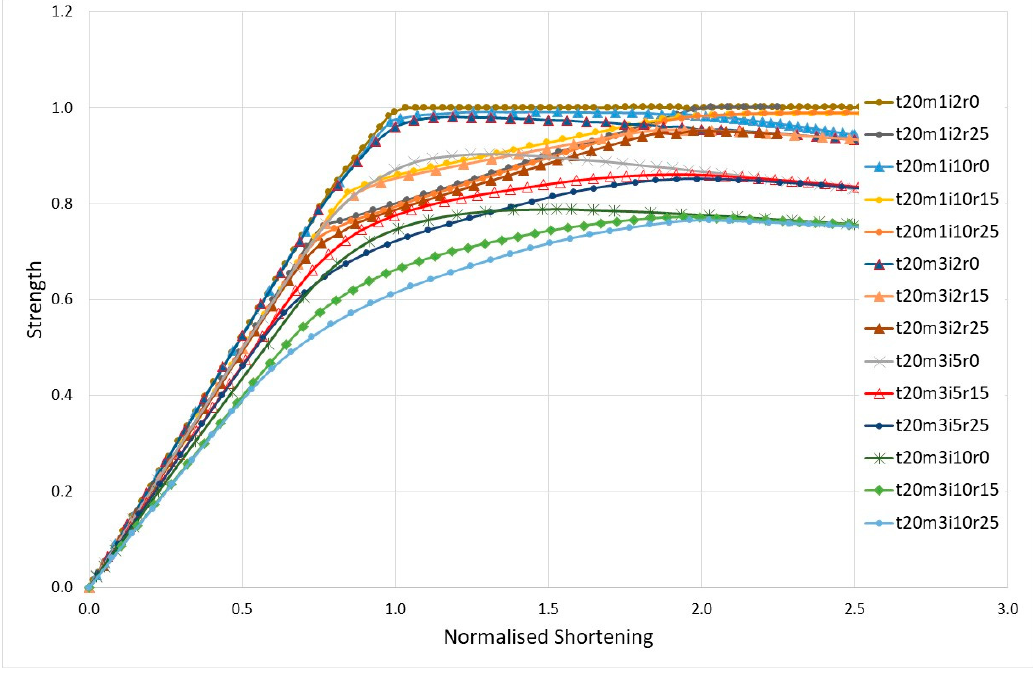
Figure 6. Load shortening curves for stocky plates with different initial imperfections in amplitude ( i = 2, 5 and 10 mm) and mode ( m = 1, 3), and several levels of residual stresses (r = 0, 0.15 and 0.25%). Table 1. Summary of data and main results for plates with a = 1.5 m, b = 0.6 m and t = 20 mm.